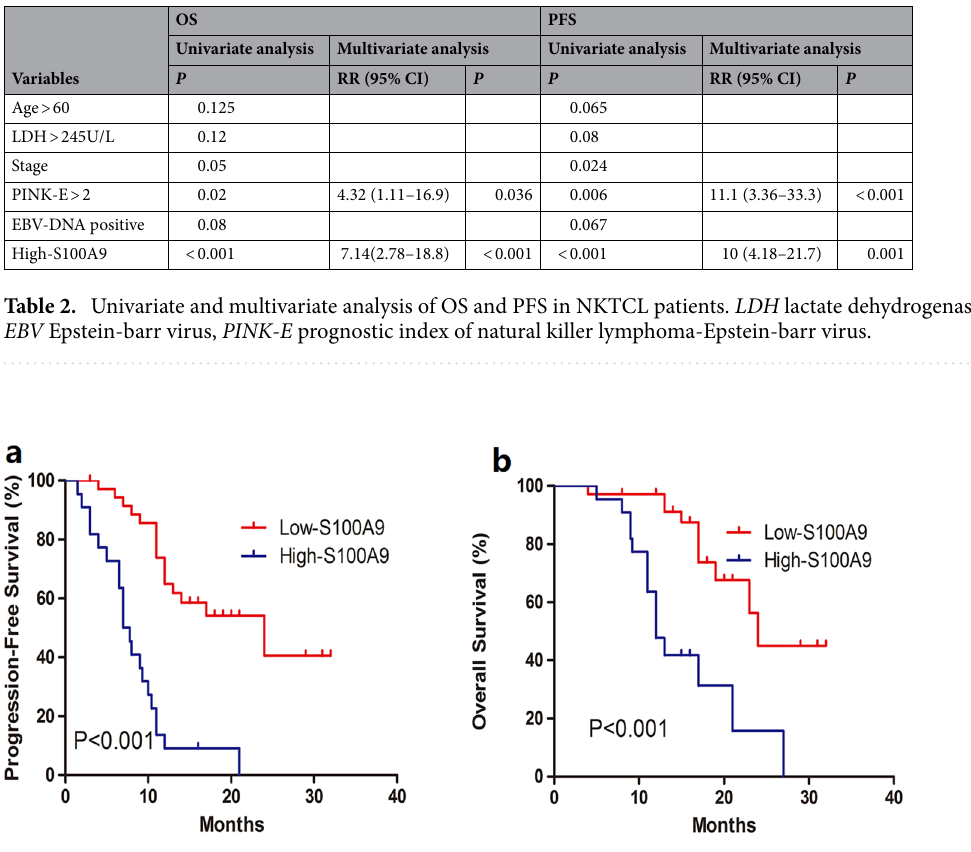
Figure 7. Survival analysis of patients according to the serum levels of S100A9. Patients with high S100A9 levels was associated with inferior PFS ( P < 0.001) and OS ( P < 0.001) than those with low S100A9 (Figure 7a and